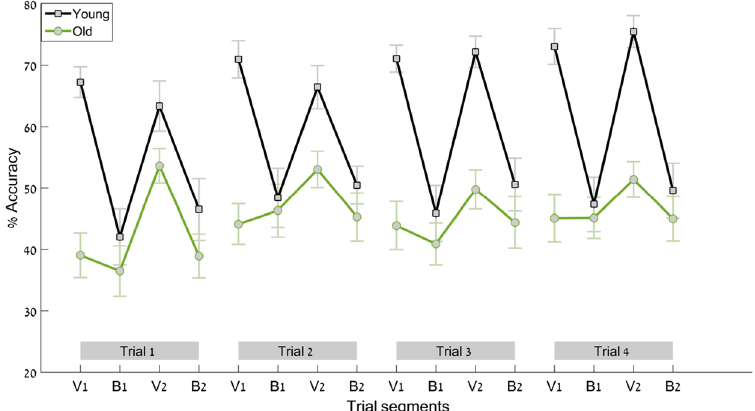
Figure 4. Accuracy. Shown here are the non-normalized accuracy values (the percent of the total trial time spent inside the target zone) for all 16 trial segments (four trials with four segments each), for the young group (in black) and for the old group (in green). Error bars denote standard